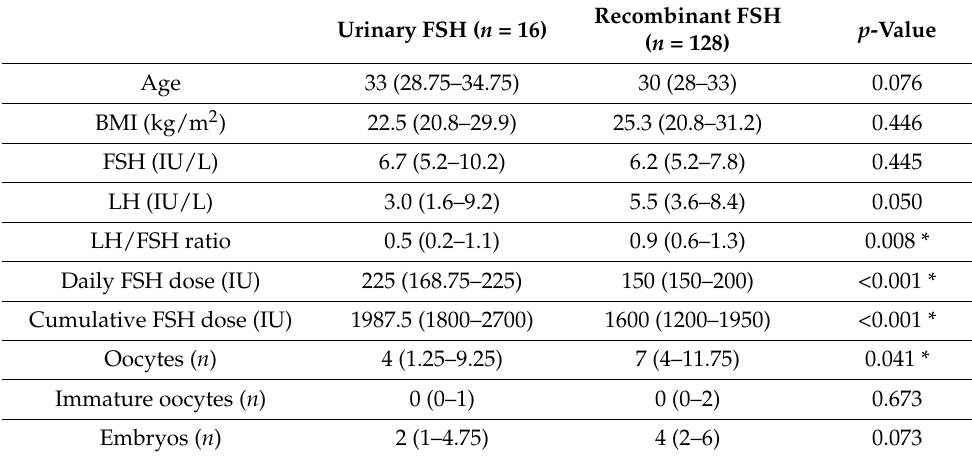
Table 2. Comparison of hMG versus rFSH used for OS. Statistically significant differences are marked with an asterisk ( p -value < 0.05).